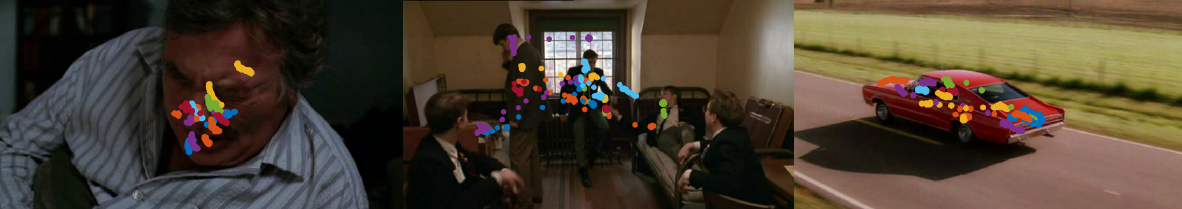
Figure 1. Sample scenes from the Hollywood2 data set overlaid with 600 ms of gaze samples. The gaze pattern of each participant is visualised with a unique colour. The left and right snapshots show scenes with substantial motion and they contain 72% and 59% of smooth pursuit respectively. The high prevalence of pursuit is also visible by the elongated coloured lines (representing consecutive gaze samples) that are oriented along the direction of the motion. The middle snapshot does not contain smooth pursuit and the trace directions are more